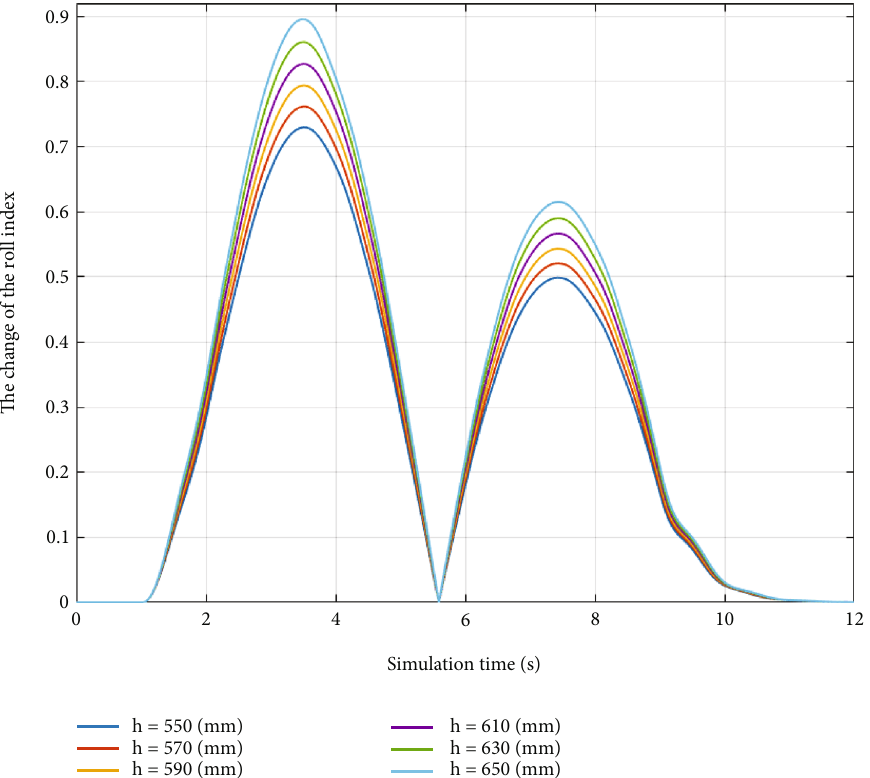
Figure 15: The change of the roll index (the third case — distance